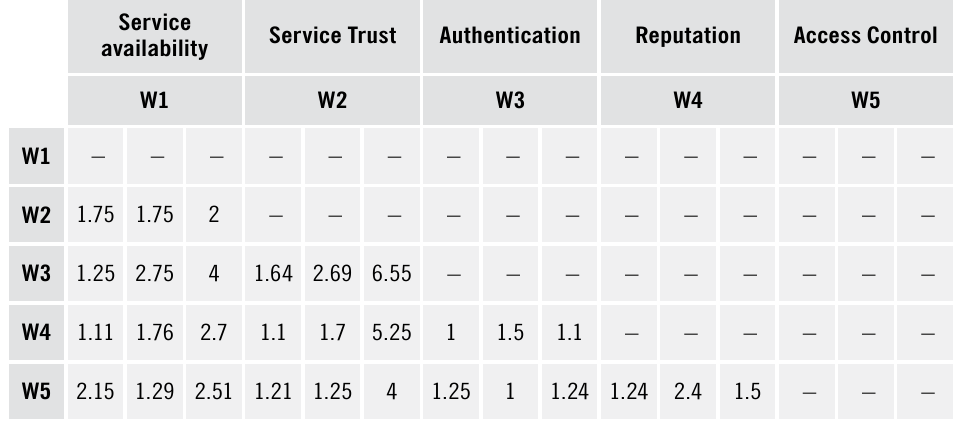
Table 4. Paired comparison matrix of security sub-criteria of service, based on experts opinions Service